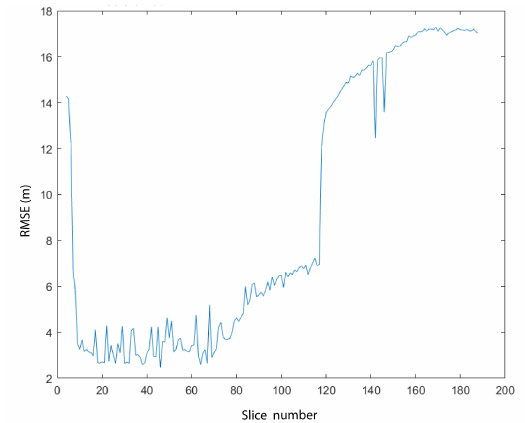
Figure 4. RMSE error on the registration depending on each slice in the global case